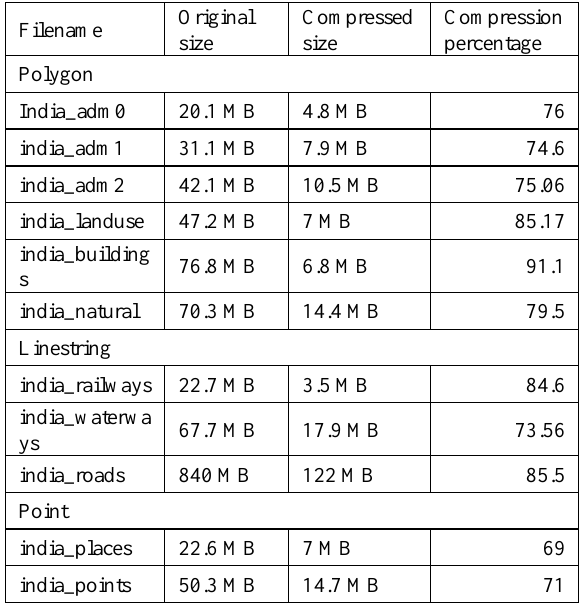
Table 1. Compression ratios of India GML files